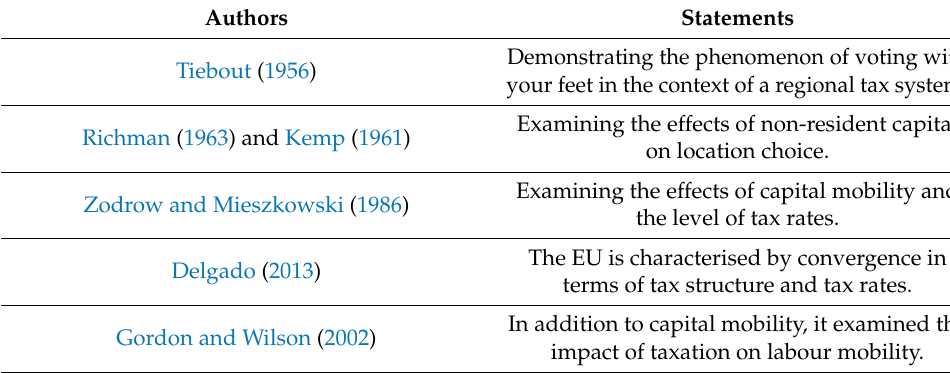
Table 2. The development of research on tax